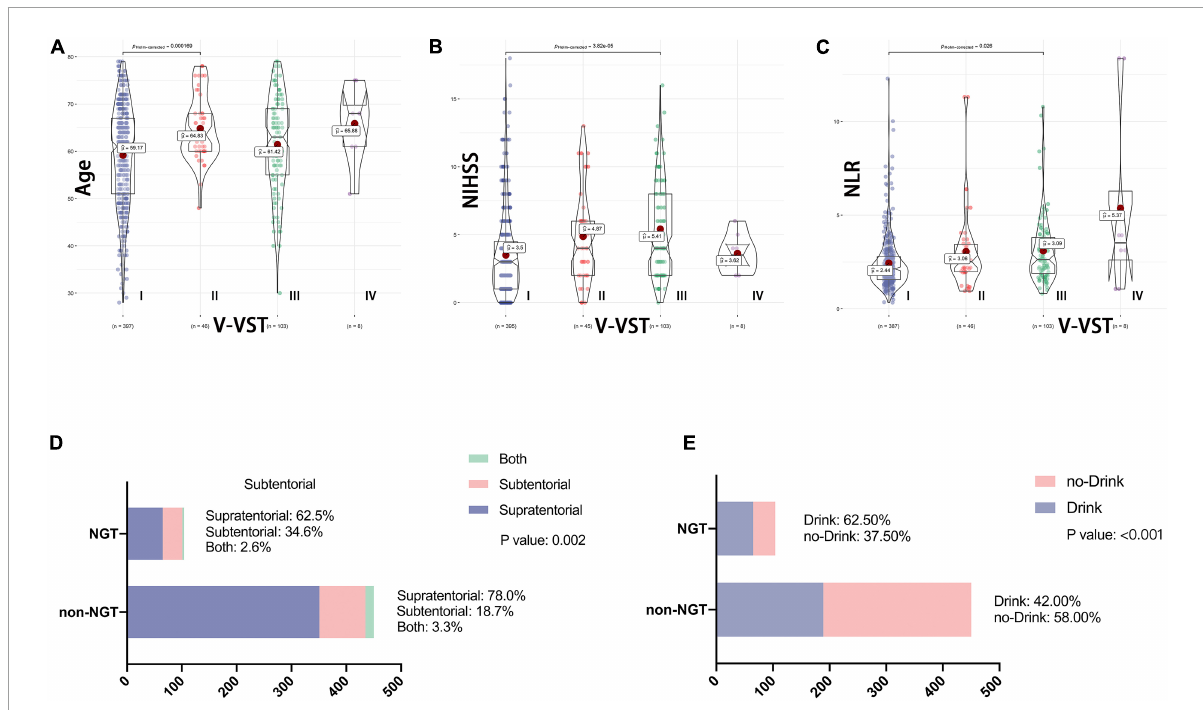
FIGURE1 Association between baseline data and swallowing function. V-VST, the volume-viscosity swallow test; NIHSS, National Institutes of Health Stroke Scale on admission; NLR, Neutrophil to lymphocyte ratio; NGT, need for nasogastric tube. Figure shows the correlation analysis between the five variables which were ultimately included in the nomogram and swallowing function. (A–C) Shows the relationship between continuous variables including age, NLR and NIHSS and V-VST, all with statistically significant differences in their V-VST grade distributions. (D,E) Shows the association between categorical variables including stroke location and drinking and NGT, again with statistical differences.